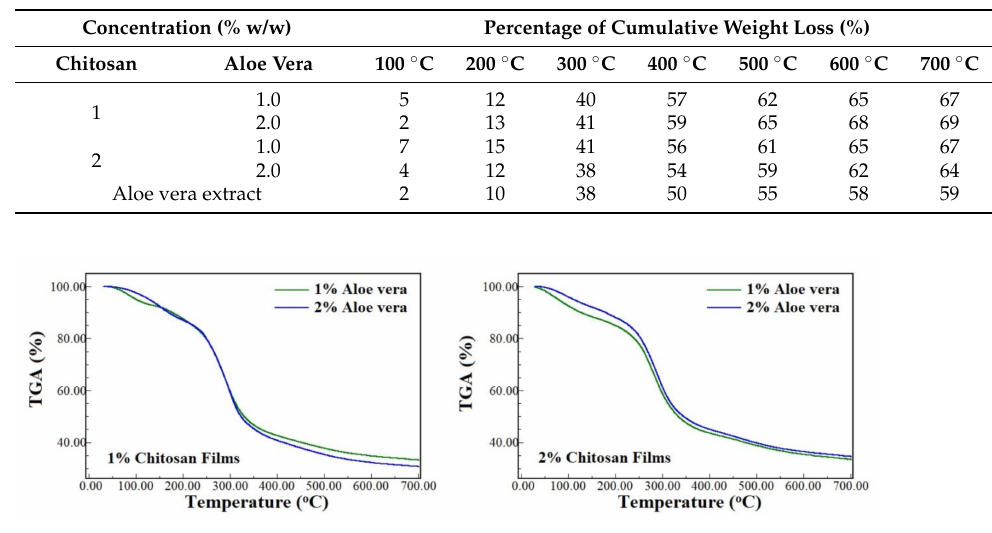
Figure 5. TGA curves of 1.0% and 2.0% chitosan films containing 1.0% and 2.0% aloe vera